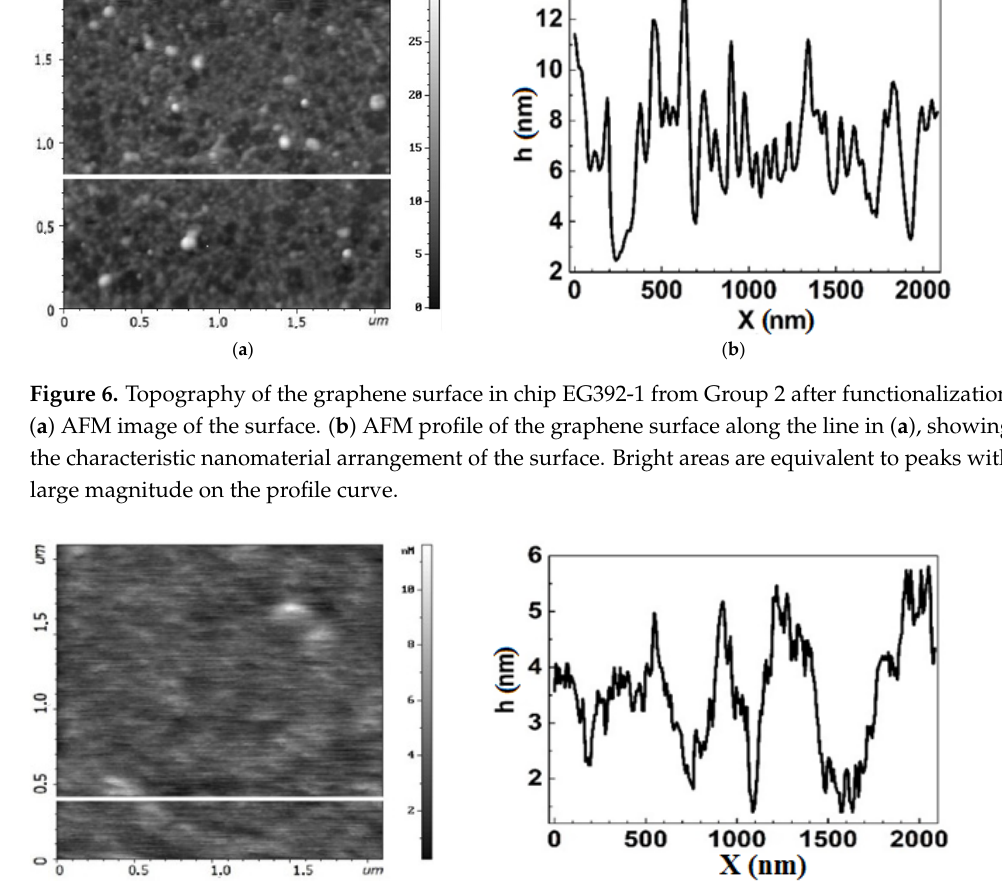
( b ) Figure 5. Topography of the graphene surface for chip EG335-5 from Group 1 before the functionalization process: ( a ) AFM image of the surface with less bright areas than in Figure 4a. ( b ) AFM profile of the graphene surface along the white line in Figure 5a, showing the characteristic arrangement of the nanomaterial of the surface. Bright areas are equivalent to peaks with large magnitude on the profile curve. There is a significant decrease in the sizes of bright areas in the chips of Group 2 (Figure 6) and Group 1 (Figure 7) after functionalization. Meanwhile, the sizes of dark regions increase up to 500 nm. The dark regions are similar to shallow pores in plain or large honeycomb-like defects non-uniformly distributed over the chip area. Thus, we can